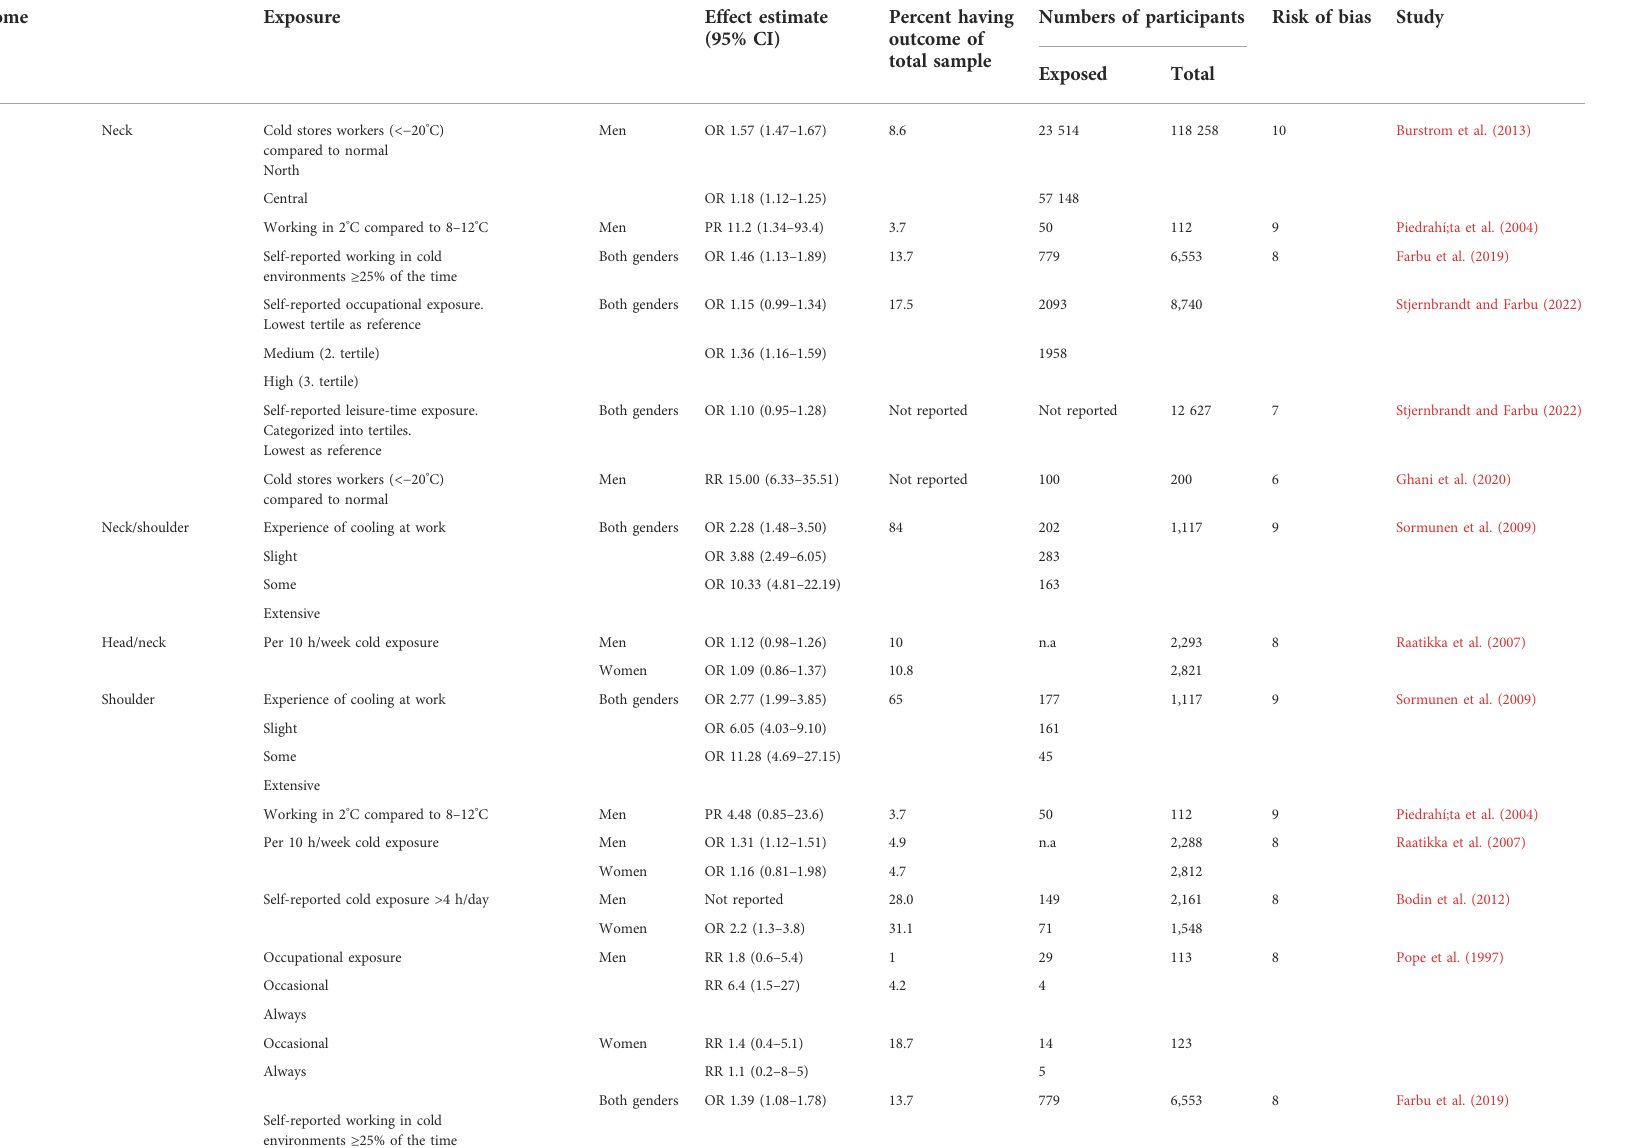
TABLE 3 ( Continued ) Effect estimates sorted after type and type of assessment of pain or regional